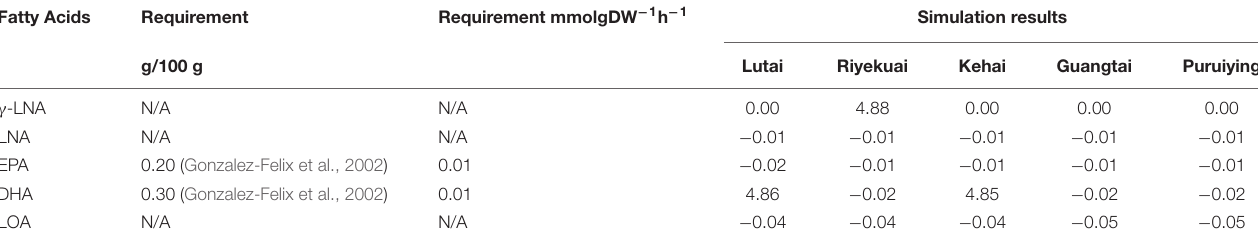
TABLE 6 | Requirements of fatty acids by L. vannamei in literature and simulation results. Fatty